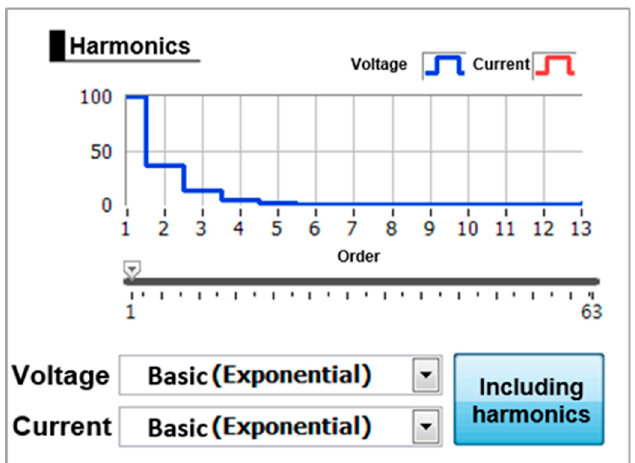
Figure 8. Internal waveform generation including harmonics.